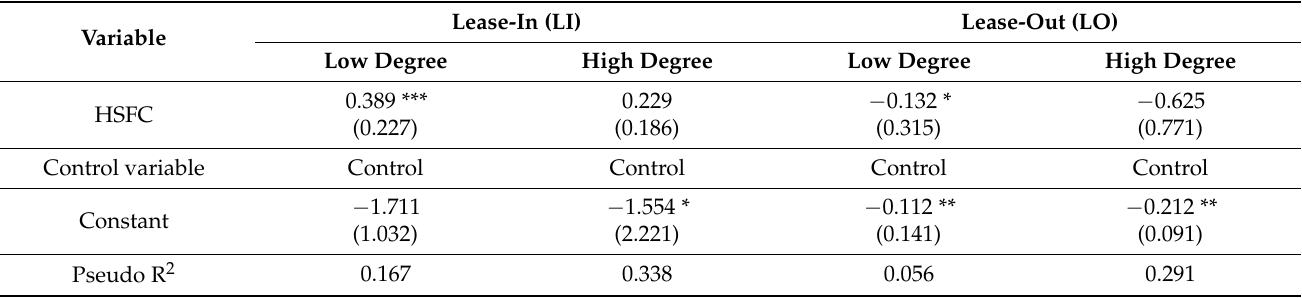
Table 5. Result of heterogeneity